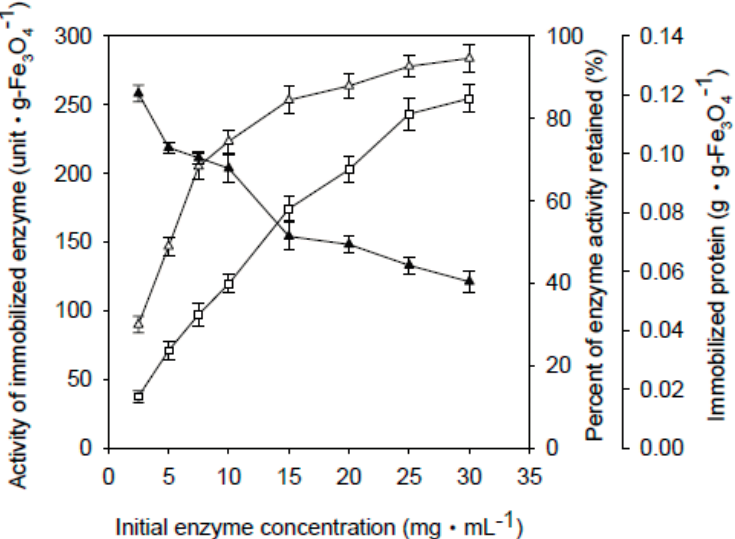
Figure 2. Adsorption equilibria of Fe 3 O 4 -CS-immobilized β -galactosidase. Experimental details are the same as that of Figure 1. The data are averaged from three